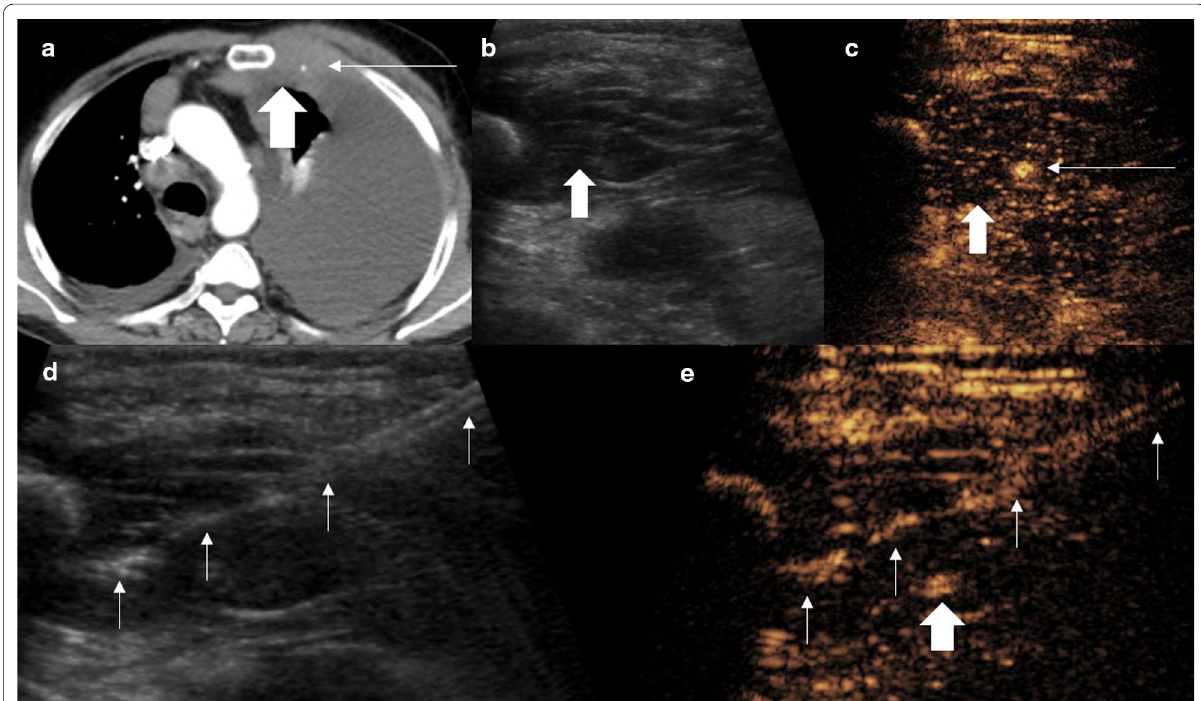
Fig. 7 Male patient with chest wall swelling. a A CT examination showed focal soft tissue thickening (arrow) encasing the internal mammary artery (IMA) (thin arrow). b On the B mode ultrasound, the lesion (arrow) blends with striated muscle but the IMA is not seen. c CEUS defines the hypoenhancing pathological tissue (arrow) encasing the IMA (thin arrow). d , e Simultaneous B mode and CEUS imaging with an 18‑gauge biopsy needle (thin arrows) advanced to the lesion avoiding the IMA (arrow). The lesion was histologically proven